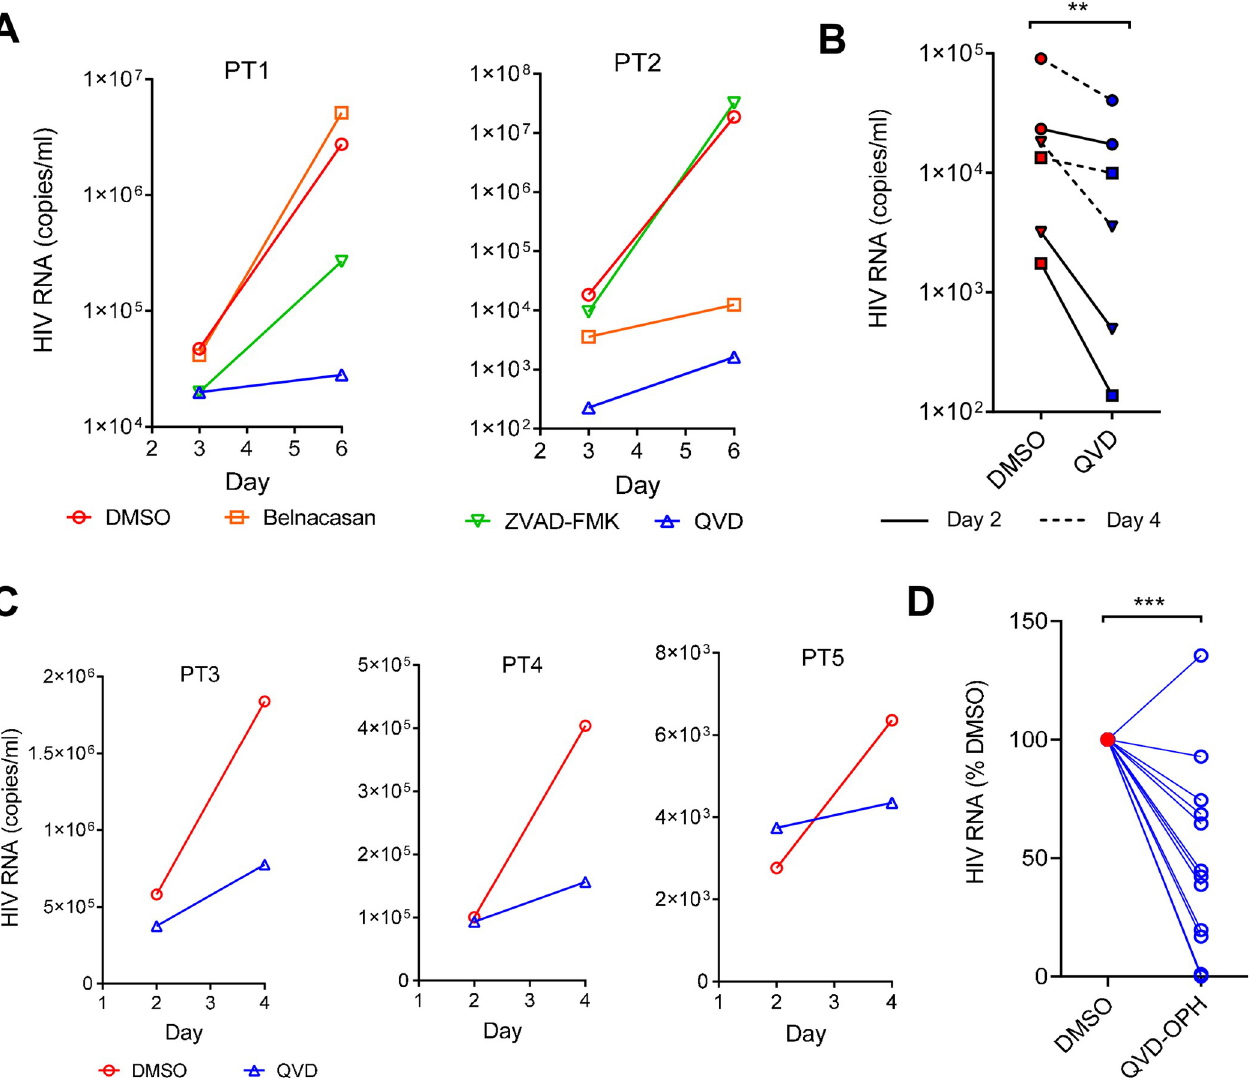
Fig 7. Caspase Inhibitor suppresses the ex vivo viral reservoir. (A) HIV viral release was measured as HIV RNA copies/ml in the presence of various caspases inhibitors or DMSO from CD4 T cells derived from infected individuals but stimulated in vitro with anti-CD3 for 3 and 6 days. PT1 and PT2 are two infected viremic individuals not receiving ART treatment. (B) Effect of QVD-OPH in suppressing HIV release from viral reservoirs. Viral RNA (copies/ml) were quantified from CD4 T cells in day 2 and 4 of anti-CD3 stimulated culture supernatants in the presence of QVD-OPH or DMSO from three aviremic individuals on ART treatment. (C) QVD-OPH inhibited HIV viral release from non-stimulated CD4 T cells derived from three infected individuals. (D) Percentage of HIV released from CD4 T cells with QVD treatment compared to that of DMSO from all infected viremic and aviremic individuals. The p-value is calculated using ordinary two-way ANOVA between QVD and DMSO treated